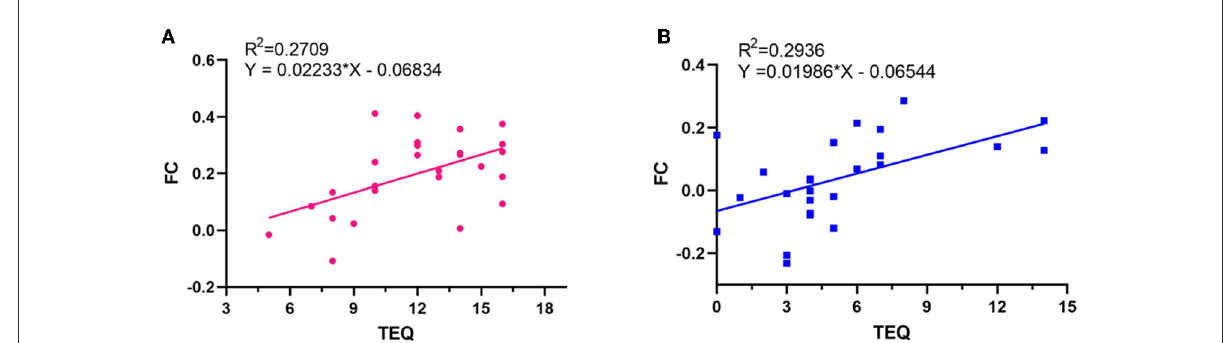
FIGURE6 Relationships between FC and TEQ scores. (A) At pre-acupuncture. (B) At post-acupuncture.